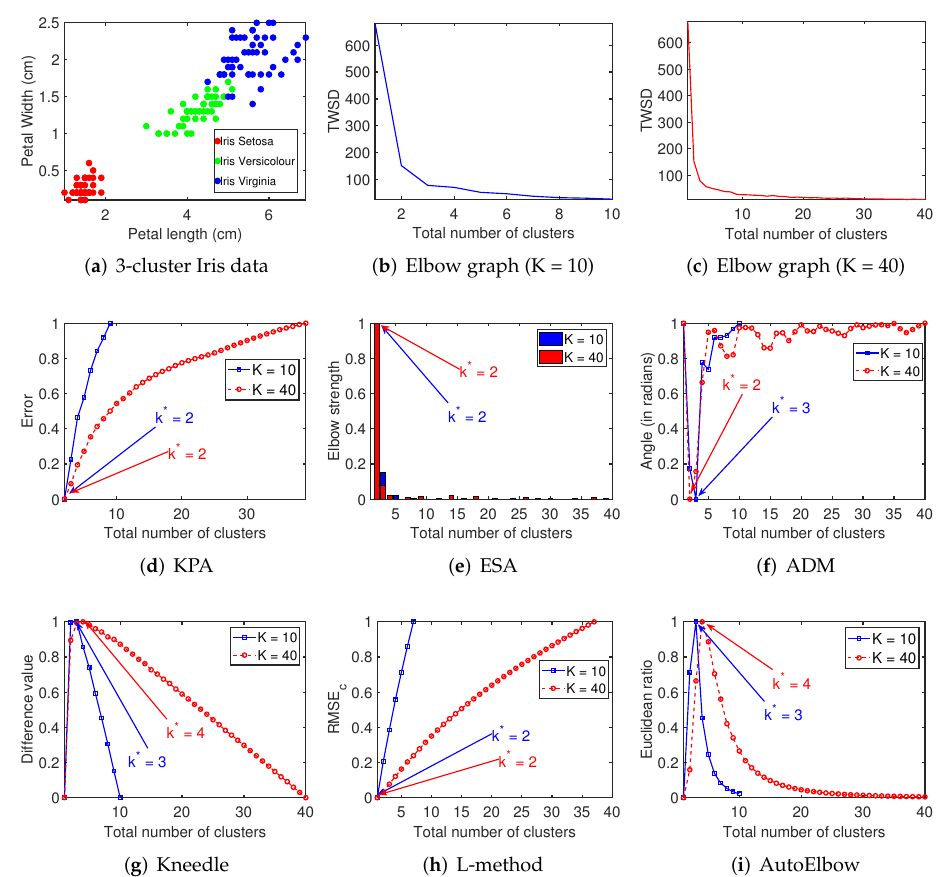
Figure 3. Small cluster number case study: three